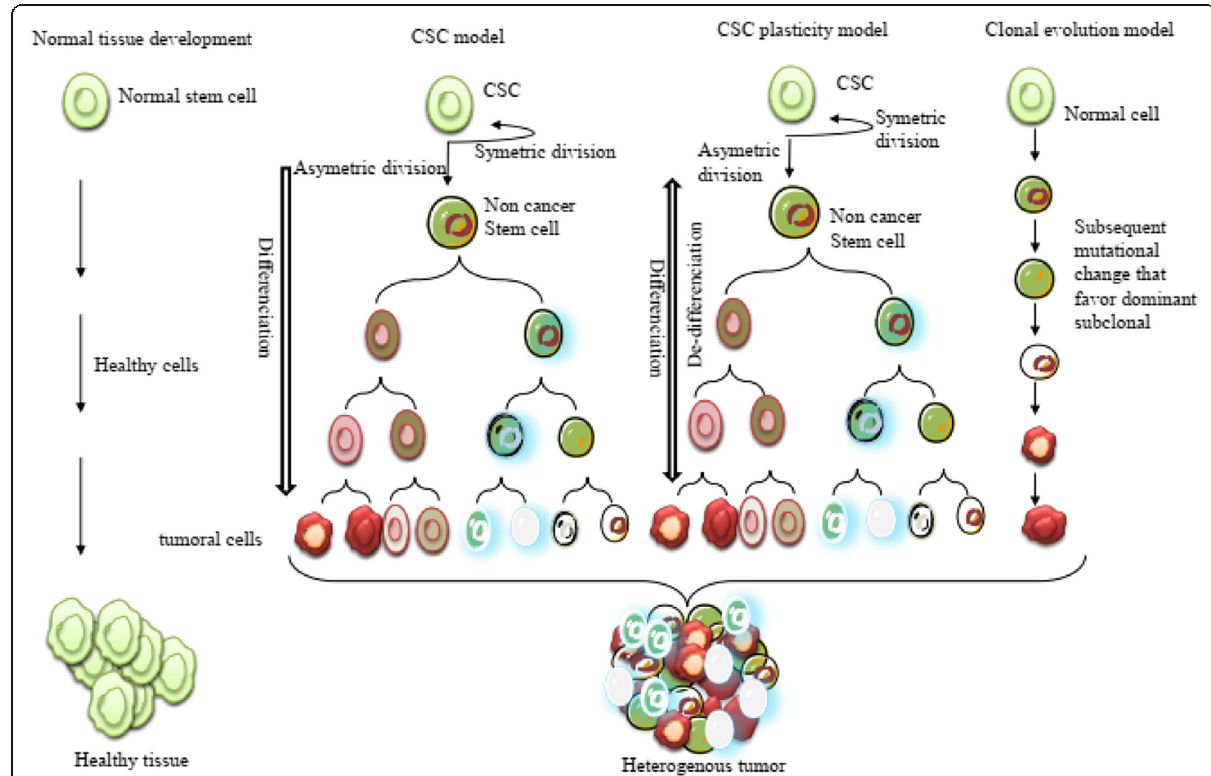
Fig. 2 Intratumoral heterogeneity models. The clonal evolution model suggests that intratumoral heterogeneity emerges from Subsequent mutational change that favors dominant sub clonal cells. Intratumoral heterogeneity sets up through cell differentiation according to the cancer stem cell model. The cancer stem cell plasticity model supports that intratumoral heterogeneity could be sourced from dedifferentiation of neoplastic